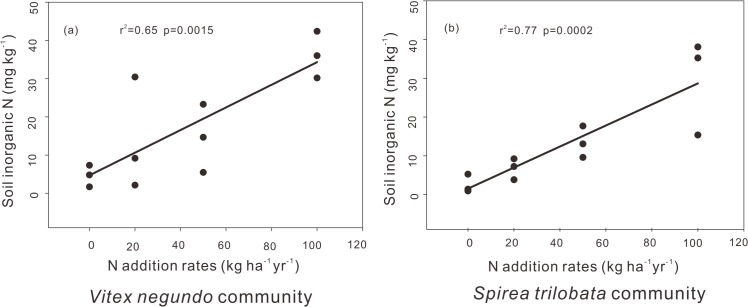
Relationships between soil inorganic N and N addition rates in the Vitex negundo (a) and Spirea trilobata communities.The solid lines indicate significant linear regression at p< 0.05.